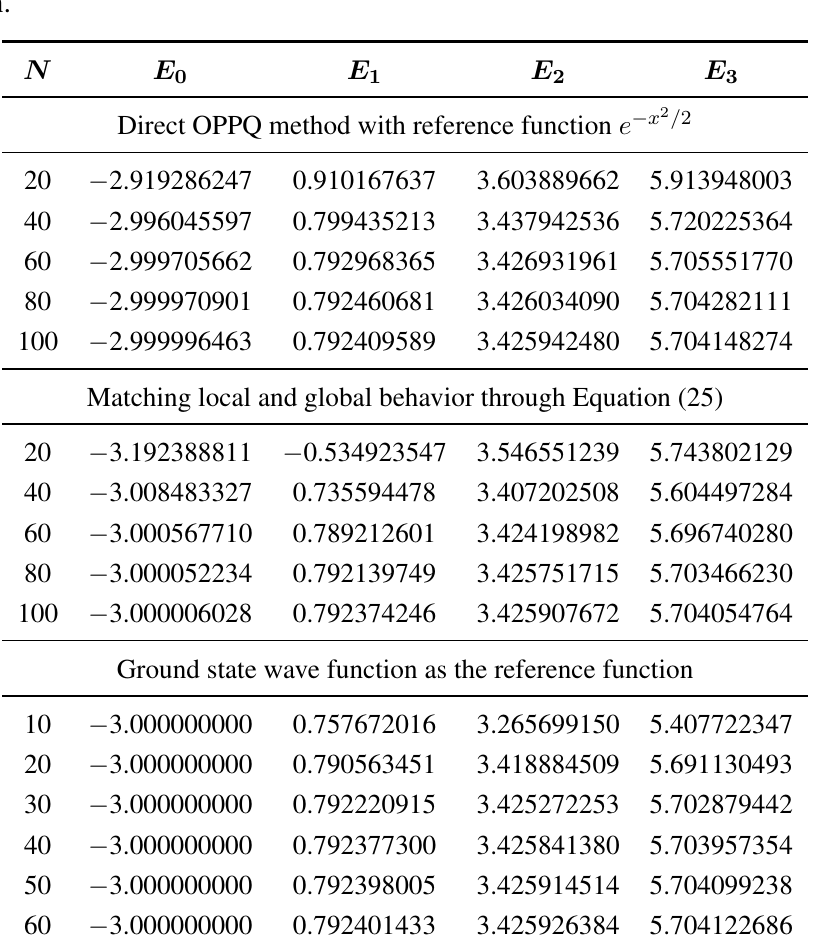
Table 2. Convergence for energy levels of the rational anharmonic potential for various methods as a function of truncation order. OPPQ, orthogonal polynomial projection